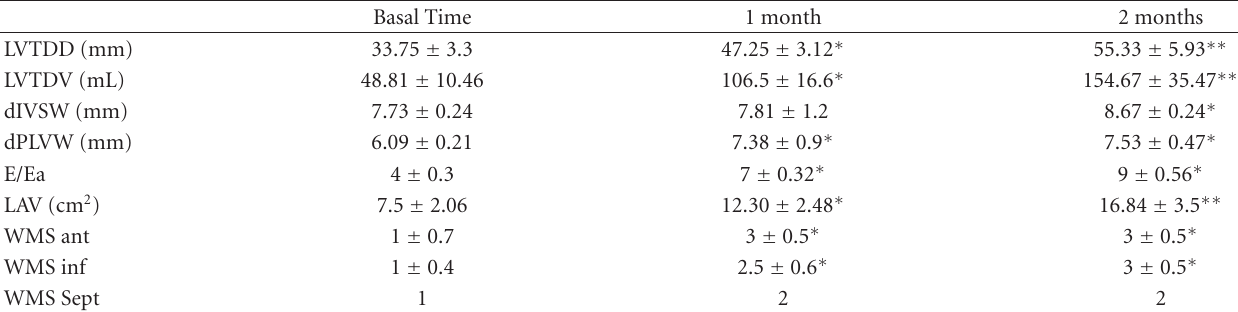
Figure 7: (a) Staining with Masson’s trichrome stain comparing a healthy zone (inferior wall of the left ventricle) with an ischemic zone (anterior wall with similar results for lateral wall). No necrosis was found demonstrating the absence of myocardial infarction. (b) Immunostaining with fluorescence of lectin found significant reduction in capillary density in anterior compared to the inferior wall. Table 1: Morphometric and functional analysis at basal time and during the follow-up. LVTDD: Left Ventricle TeleDiastolic Dimension. LVTDV: Left Ventricle TeleDiastolic Volume, dIVSW: diastolic InterVentricular Septal Wall, dPLVW: diastolic Posterior Left Ventricle Wall, E/Ea: Peak mitral inflow velocity—E- and Early diastolic—Ea-peak myocardial velocities with Tissue Doppler Imaging, LAV: Left Atrial Volume, WMS ant: Anterior Wall Motion Score, WMS inf: Inferior Wall Motion Score, and WMS Sept: Septal Wall Motion Score. Data are in mean ± SD. ∗ P < . 05, ∗∗ P < . 01 compared to basal time. Basal Time 1 month 2